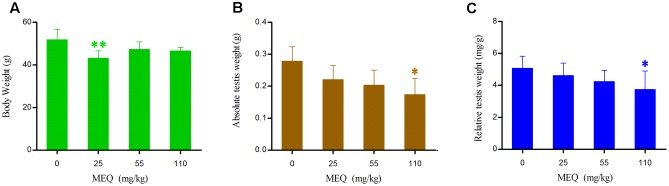
Body weight (A), Absolute testis weight (B) and Relative testis weight (C) of male mice after the administration of MEQ for 18 months. ∗p < 0.05 in comparison with control, and ∗∗p < 0.01 in comparison with control. Values represent means ± SD (n = 10).